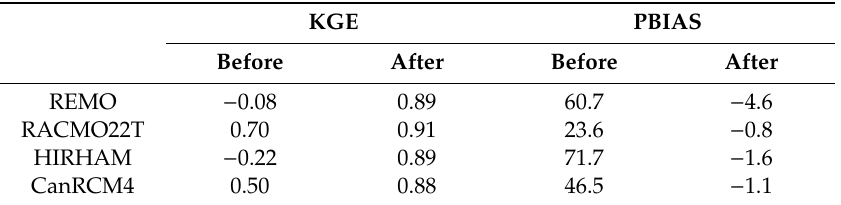
Figure 6. Comparison of raw and bias corrected rainfall with observation at daily scale over the historical period 1971–2005. Efficiency coefficients computed for the bias correction at daily scale is summarized in Table 6. Table 6. Bias correction efficiency at daily scale.